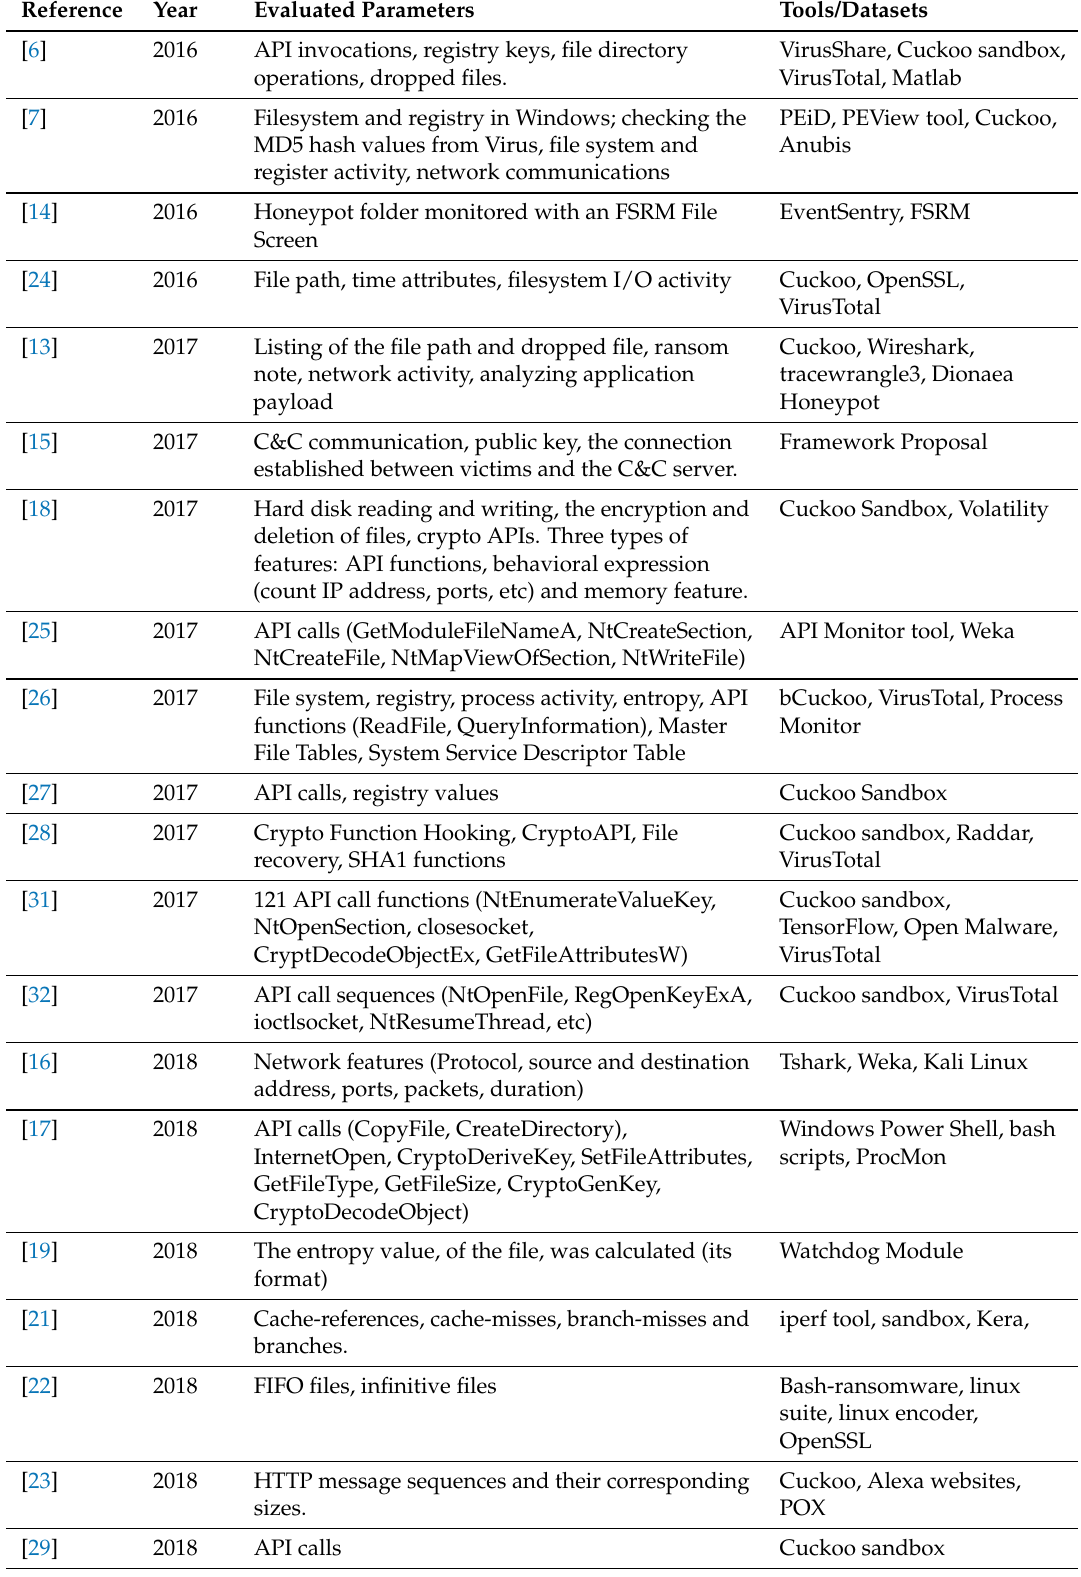
Table 2. Summary of evaluated parameters and